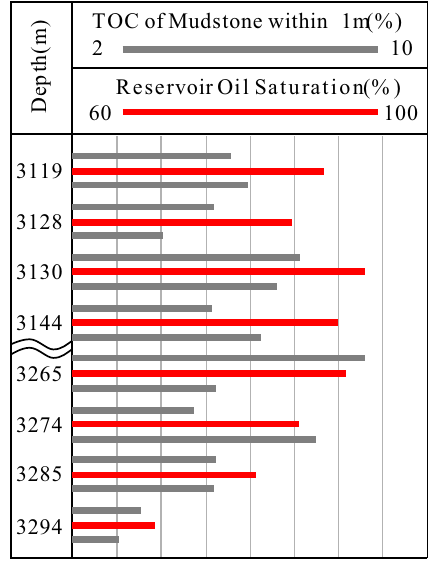
Fig. 6 TOC of mudstone within 1 m and reservoir oil saturation of the Lucaogou Formation in W174 well